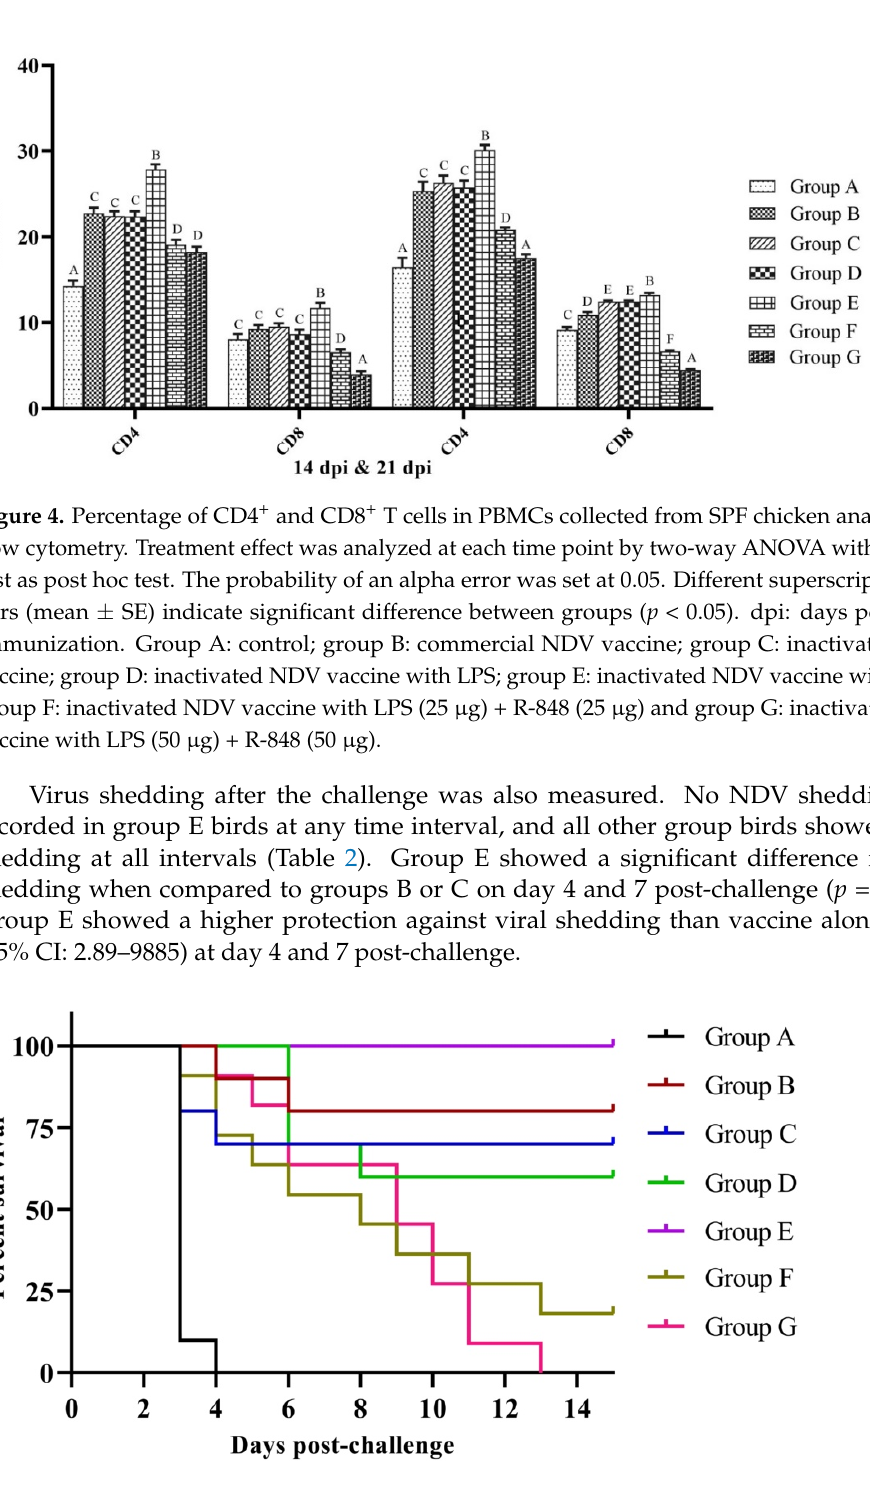
Figure 5. Survival analysis (Kaplan–Meyer analysis) of experimental SPF chicken following challenge with virulent Newcastle disease virus. The survival curve was statistically different ( p < 0.0001) with a chi-square value of 73.13 and df 6. Group A: control; group B: commercial NDV vaccine; group C: inactivated NDV vaccine; group D: inactivated NDV vaccine with LPS; group E: inactivated NDV vaccine with R-848; group F: inactivated NDV vaccine with LPS (25 µ g) + R-848 (25 µ g) and group G: inactivated NDV vaccine with LPS (50 µ g) + R-848 (50 µ